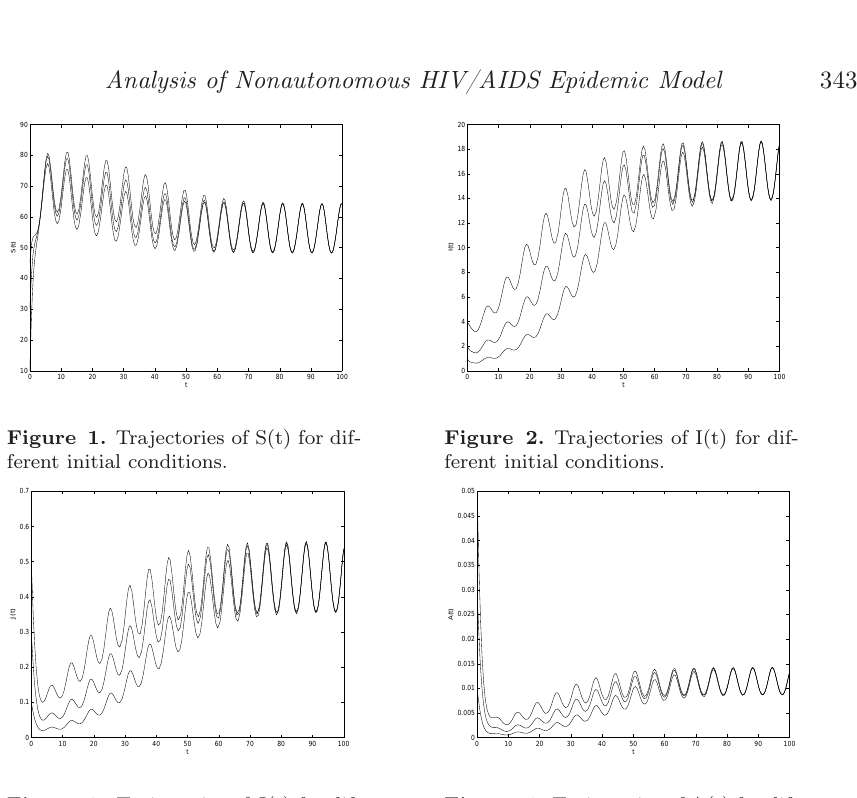
Figure 4. Trajectories of A(t) for dif- ferent initial